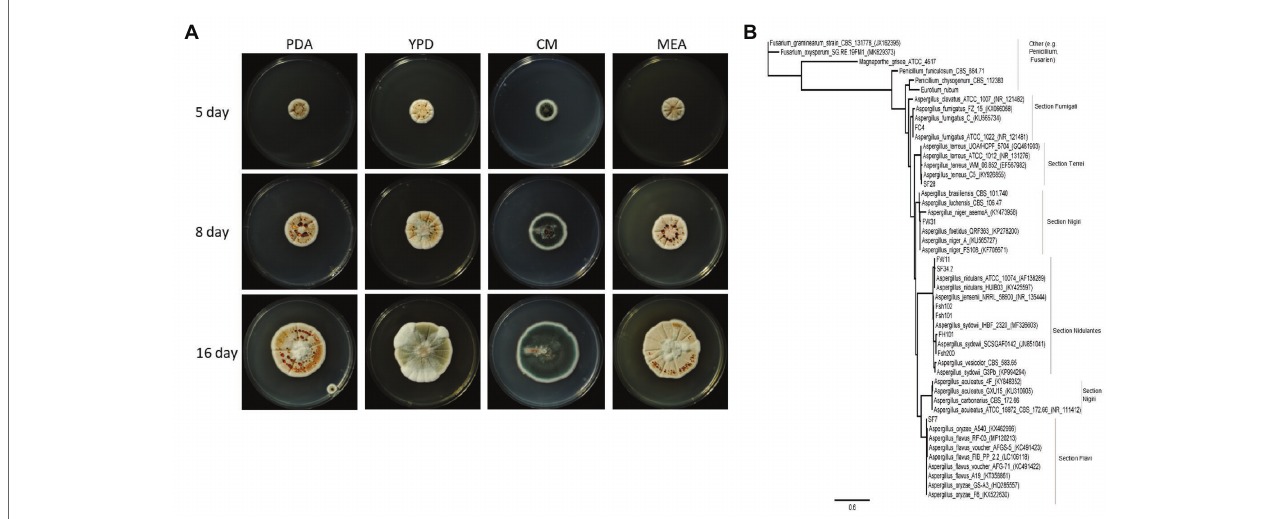
FIGURE 1 | (A) Overview of the growth of Aspergillus sydowii Fsh102 using four different media. The cultures were incubated at 28 ° C for 16 days. Pictures were taken after 5, 8, and 16 days. PDA, potato-dextrose-agar; YPD, yeast extract peptone dextrose; CM, complete media; and ME, malt extract agar. (B) Phylogenetic tree from Aspergillus clades of ITS sequences from the unique fungal strain collection from Vietnam (Brandt et al., 2018) with two strains of Fusarium and one for Magnaporthe grisea , as well as one for Eurotium rubum . Phylogenetic tree highlighting the position of A. sydowii isolate and closely related type strains. The tree was inferred from aligned internal transcribed spacers 1 and 2 without adjacent ribosomal genes. Phylogenetic tree was inferred under the maximum likelihood (ML) criterion using the PhyML function in geneious ® applying the Jukes Cantor substitution model